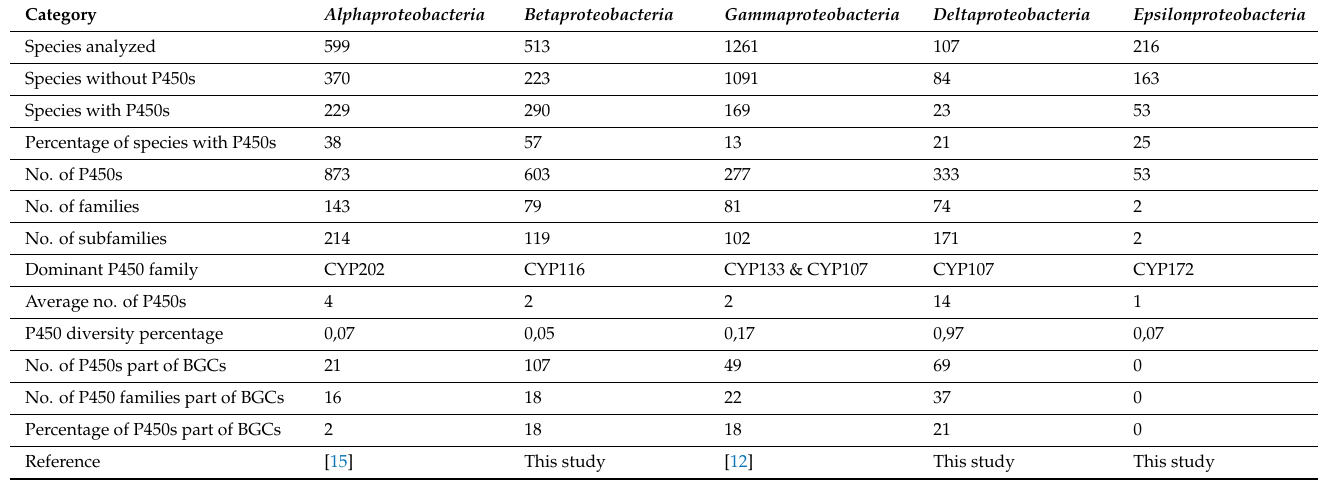
Table 1. Comparative analysis of key features of P450s and their association with secondary metabolism in different proteobacterial species. Abbreviation: No or no., number of; BGCs: biosyn- thetic gene